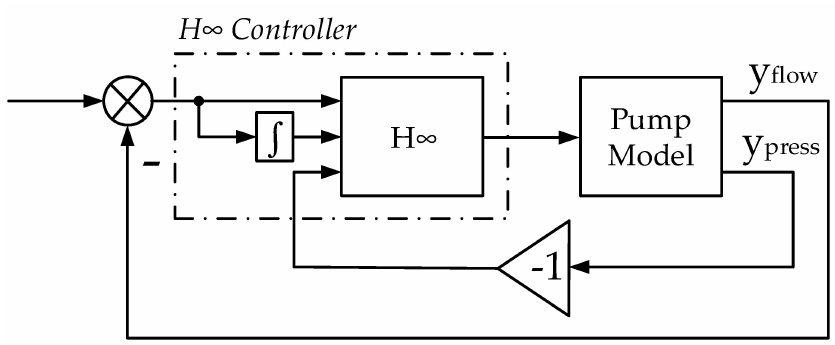
Figure 11. Structure of closed-loop system with H ∞